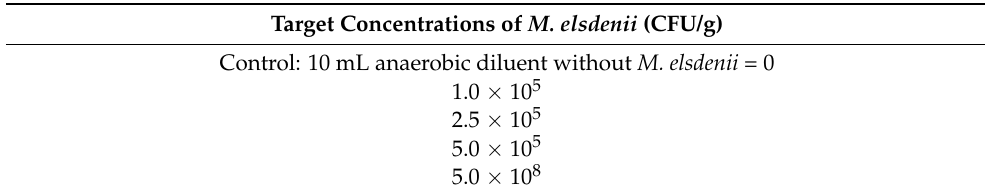
Table 1. Addition of Lactipro NXT ® in 10 mL anaerobic diluent to achieve target concentrations of Megasphaera eldenii in cattle ruminal fluid and feces as an in vitro model. Target Concentrations of M. elsdenii (CFU/g) Control: 10 mL anaerobic diluent without M. elsdenii =